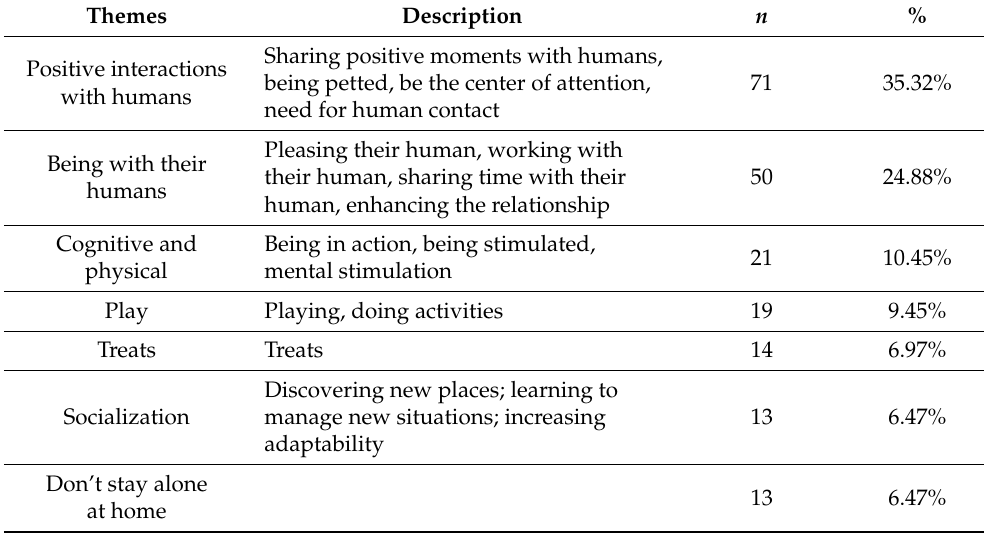
Table 4. This table represents the answers to the question “What are the benefits of working in AAI for your dog(s)”. n = 101 complete answers. Total of 201 terms coded grouped into 7 themes; presented in descending